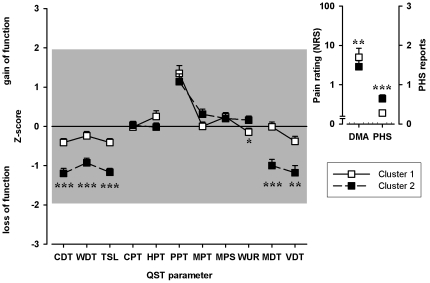
Somatosensory profiles of cluster 1 and cluster 2.Cluster 1 is characterized by a predominant preserved somatosensory function whereas cluster 2 exhibits relative loss of small fiber and large fiber function (lower Z-scores for CDT, WDT, TSL, MDT, VDT and WUR respectively). Values are given as arithmetic mean and standard error of mean. The grey marked area displays the normative range (Z-scores between +/−1.96). P-values: *<0.05, **<0.01, ***<0.001.